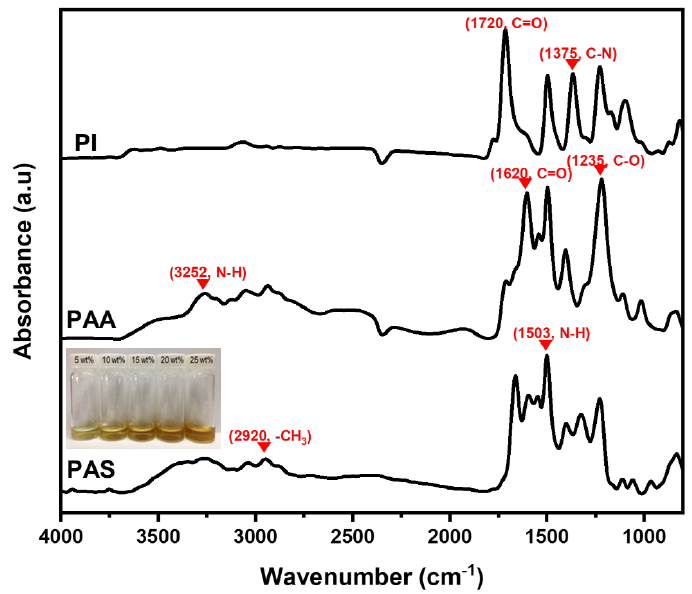
Figure 5. FT−IR spectra of PI, PAA, and PAS. Figure 5. FT-IR spectra of PI, PAA, and PAS.